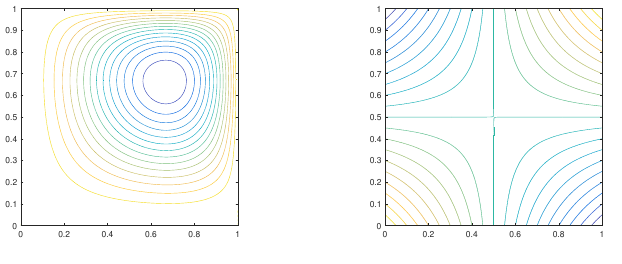
Figure 2. Computed streamlines(left) and pressure contours(right) for analytical solution with θ = 0 . 0005 by our two-level subgrid stabilized